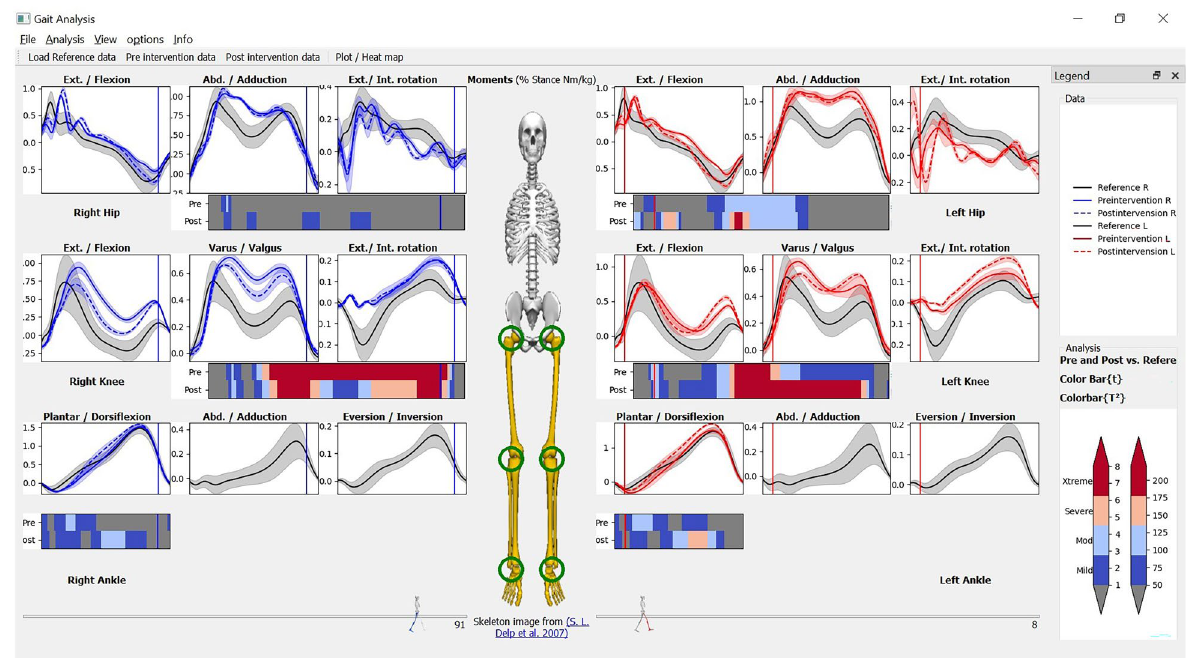
Figure 3. MovementRx after applying pre and post intervention vs reference Hotelling’s 2